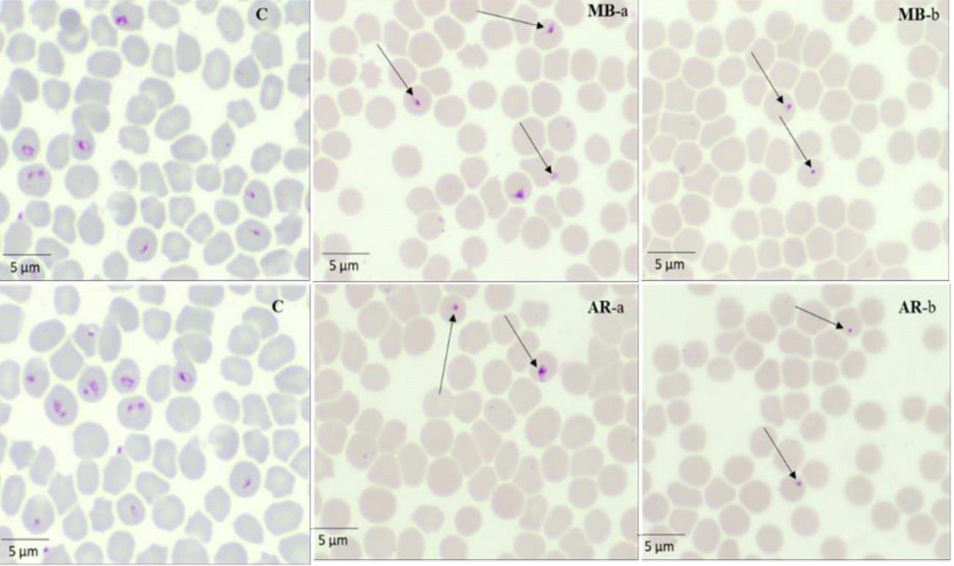
Figure 3. Morphological changes and light micrographs captured for MEBV- and AERC-treated T. equi in an in vitro culture taken after 24 (a) and 72 h (b). The arrows show the abnormal dividing parasites at 24 h. While at 72 h, drug-treated cultures showed higher numbers of degenerated parasites than did the control